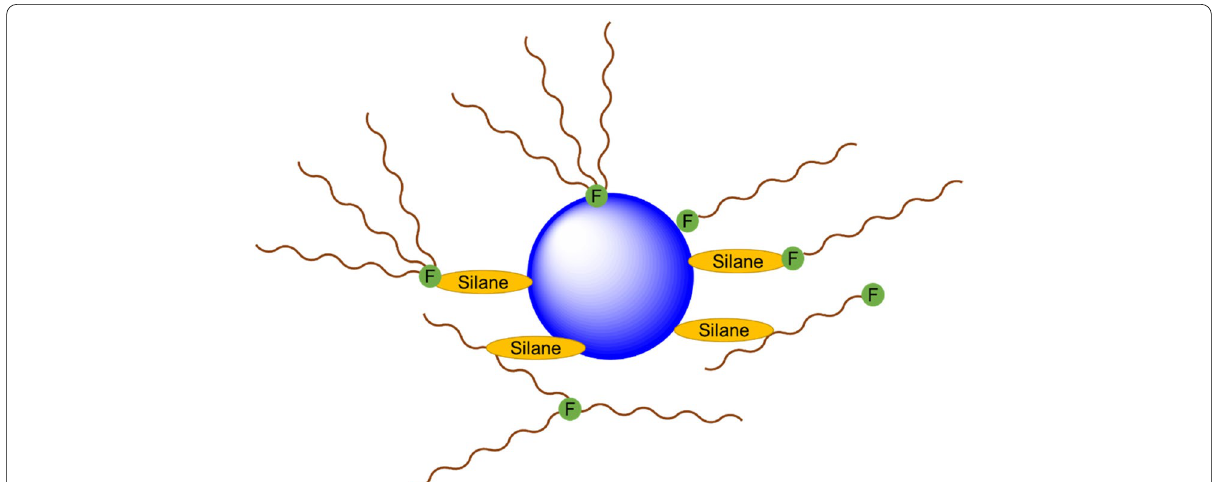
Fig. 17 Branched functionalized SBR and linear functionalized SBR